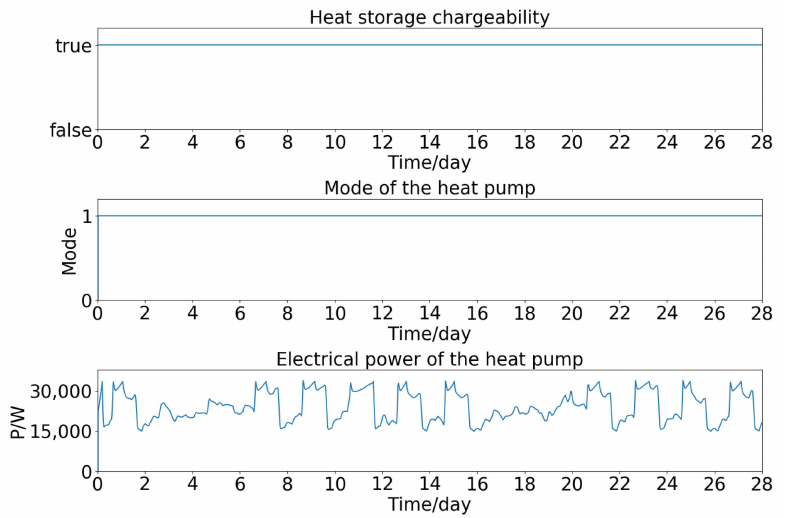
Figure 14. The simulation results of heat supply subsystem 2 containing a heat pump as time series in the winter